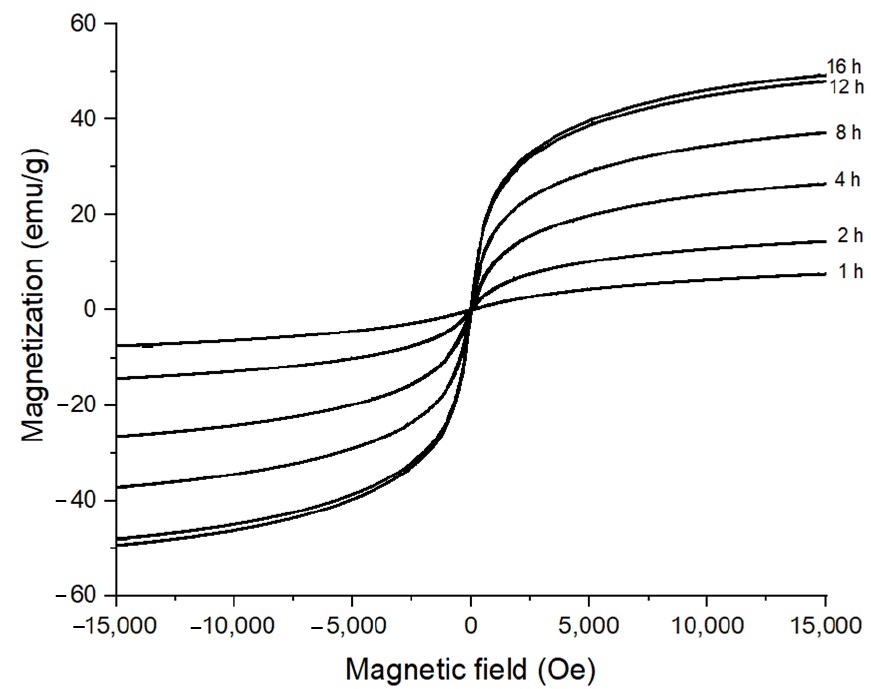
Figure 4. Room temperature M vs. H dependence of CoFe 2 O 4 nanoparticles synthesized at 180 °C in the presence of 1 M oleic acid for different reaction times.